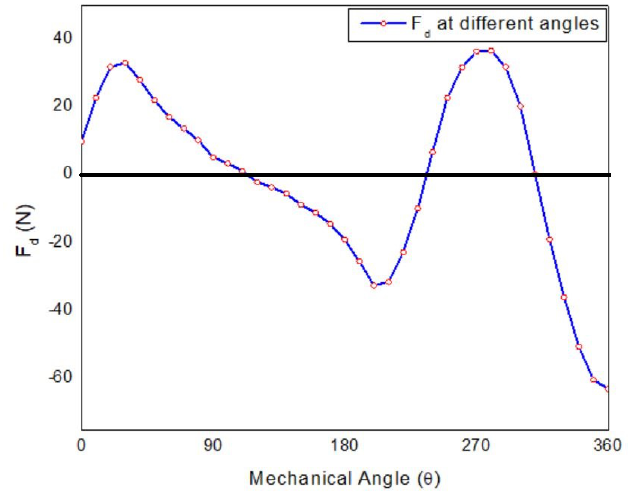
Figure 9. Detent force of the proposed model.